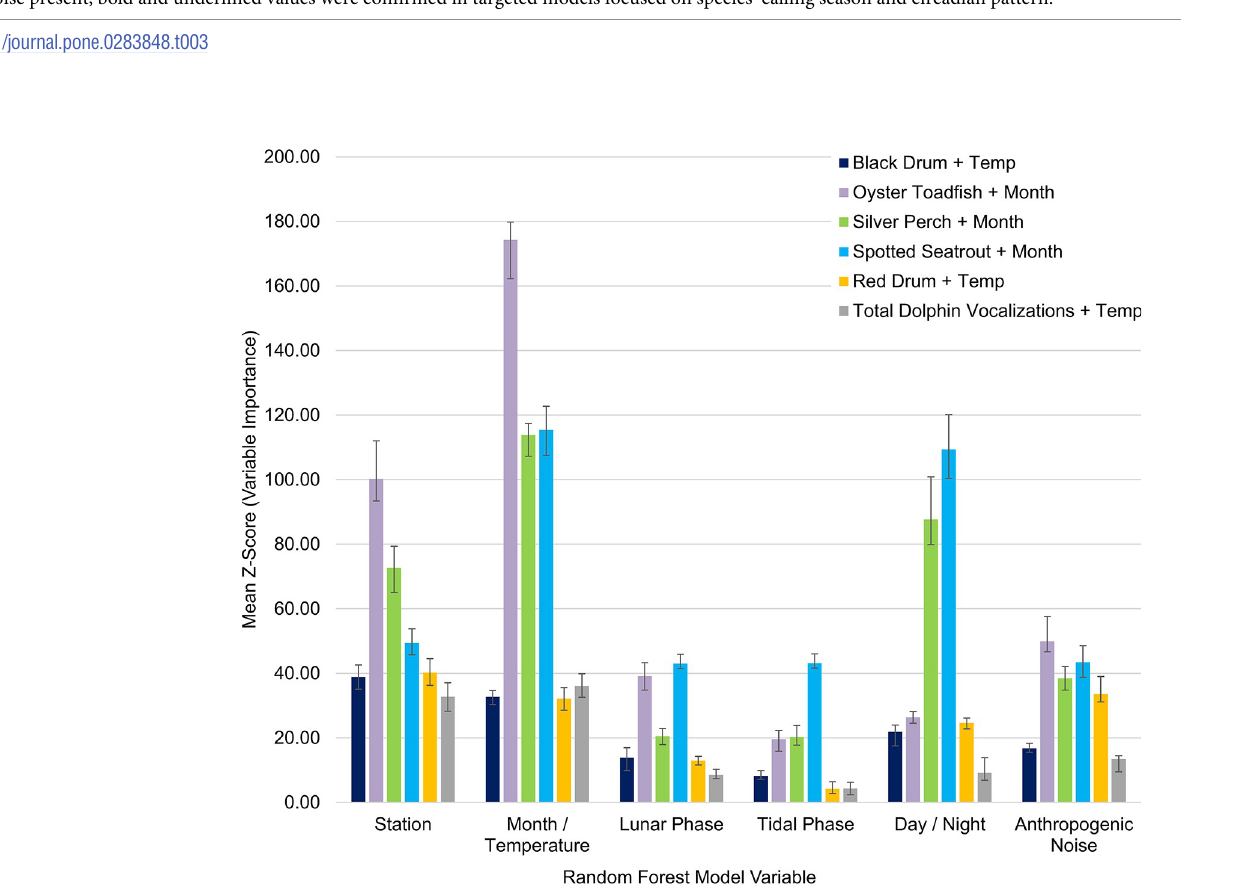
Fig 6. Boruta, random forest model variable significance and ranking for biological sound producers. Influence of spatial, temporal, and anthropogenic noise variables on calling and vocalizing for black drum, oyster toadfish, silver perch, spotted seatrout, red drum, and bottle dolphins. These models used data that were manually analyzed every hour. Bars represent the significance (mean Z-score) of each variable from the Boruta wrapper algorithm based on a random forest model. Z-score is not a statistical value, it is a comparison of data to a randomized version of the data. Error bars represent the minimum and maximum Z-score. All the factors were significant at p < 0.01. Post hoc differences can be seen in Table